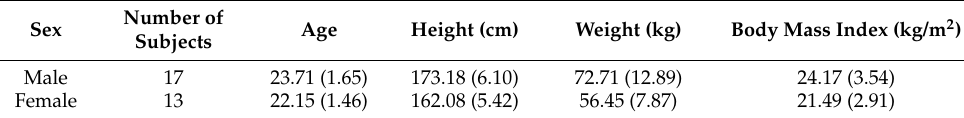
Table 1. General characteristics of the